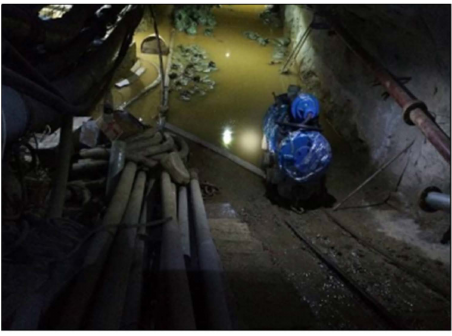
Figure 1. Disaster caused by floor water inrush in a mine working